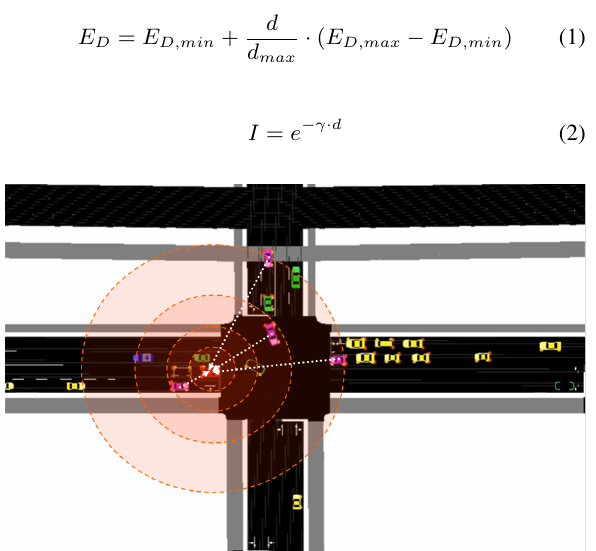
Figure 2. An example for COMAP scenario (red: ego-vehicle, magenta: data-sharing-vehicle, green: in-range-vehicles but not chosen for sharing data, yellow: not-in-range-vehicles) SUMO is responsible for the traffic flow generation and the nav- igation of vehicles based on the same map transformed from CARLA ”Town05” to SUMO xml format. In order to create enough meet up scenarios and traffic density for COMAP with limited number of vehicles and sensors, we run each simulation based only on one junction. An example of such simulation is given in figure 2. The vehicles randomly choose an entry road and an exit road that is connected to this junction and depart from the junction-opposite end of the entry road. Once they finish driving over the exit road, they will choose a entry and exit road of this junction again and find the optimal route back to the new entry road. This loop continues until the simulation reaches the pre-defined number of simulation frames or there is no CAV in the range of ego-CAV anymore. As shown in fig- ure 2, although many vehicles (green and magenta) are in the communication range (e.g. 30m) of ego-vehicle (red), Furthest Point Sampling (FPS) algorithm is used to select a maximum number (e.g. 4) of cooperative vehicles in order to avoid too